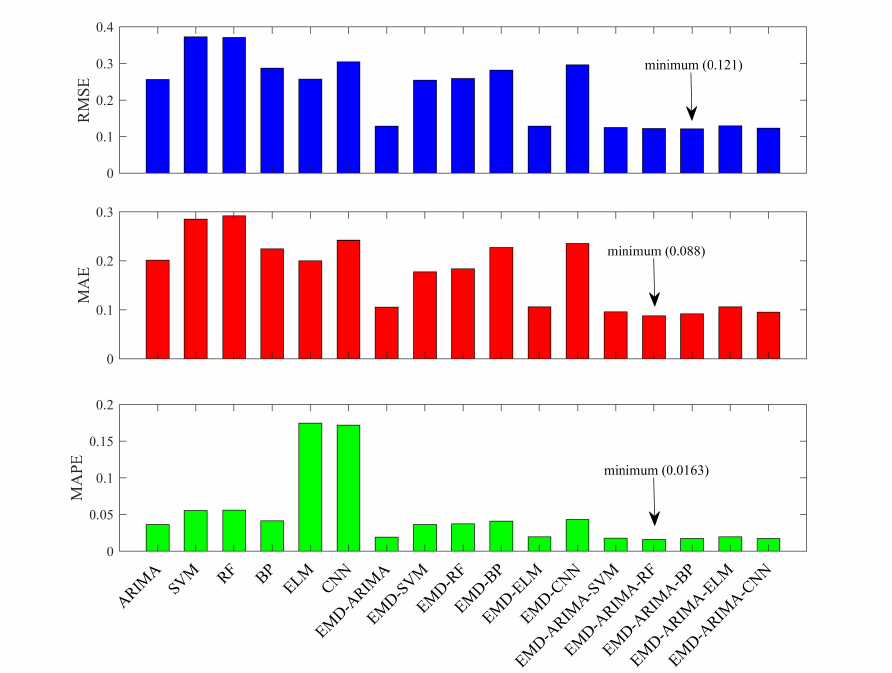
Figure 7. Wind speed prediction comparisons for the 10 min data at the GD